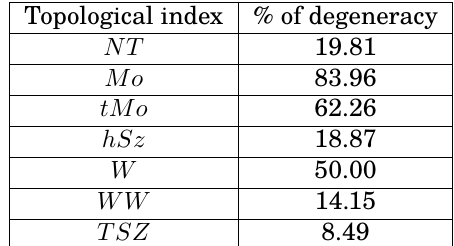
Table 1: The percent of degeneracy of listed topological indices, calculated on the set of trees with 10